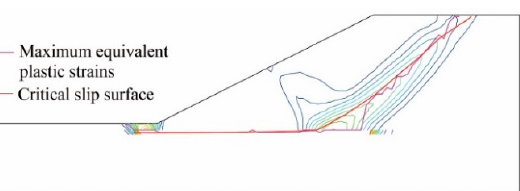
Figure 13. The contour of equivalent plastic strain, distribution of the maximum equivalent plastic strains, and the CSS for Example 2.